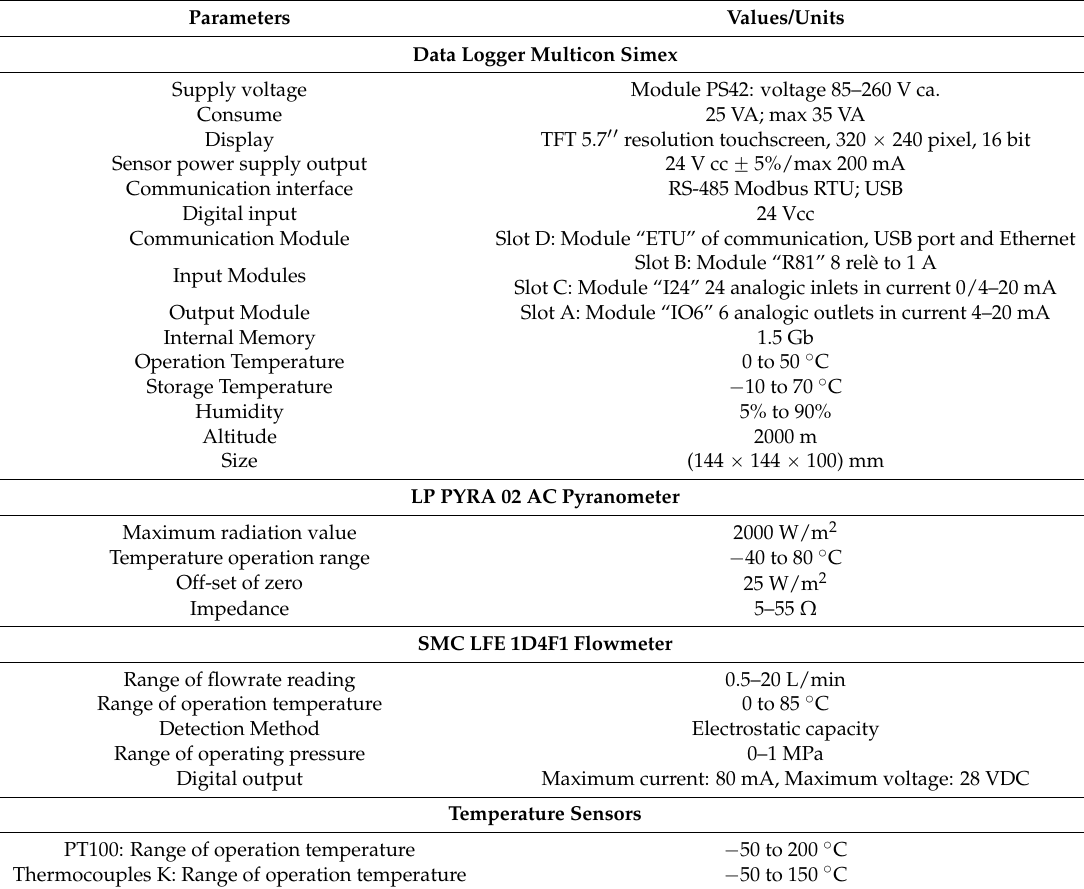
Table 4. Technical features of the set of